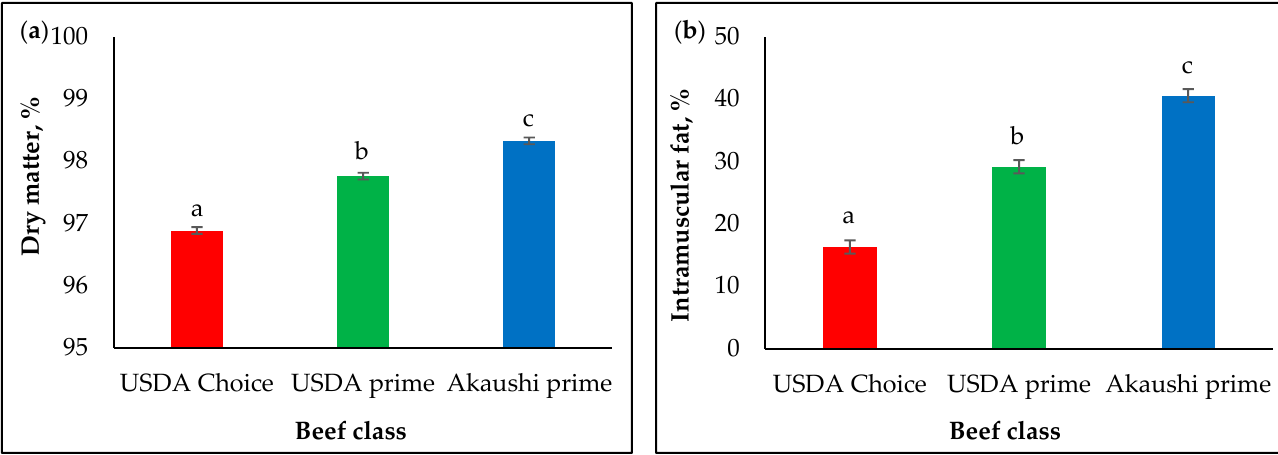
Figure 6. Quantitative analyses for dry matter and fat content evaluation of the samples. ( a ) Dry matter content, ( b ) fat content. Classes with different superscripts (a, b, c) differ by p ≤ 0.05.